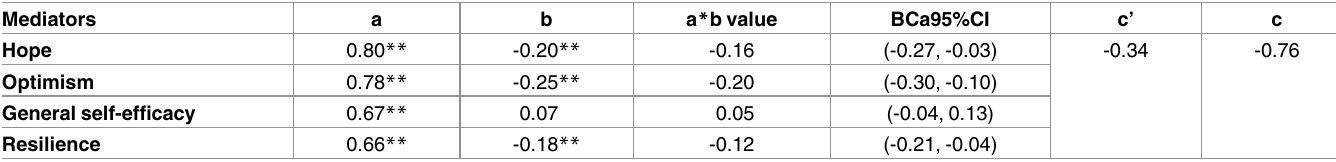
Table 4. Mediating roles of positive psychological constructs on the PSS-fatigue association.